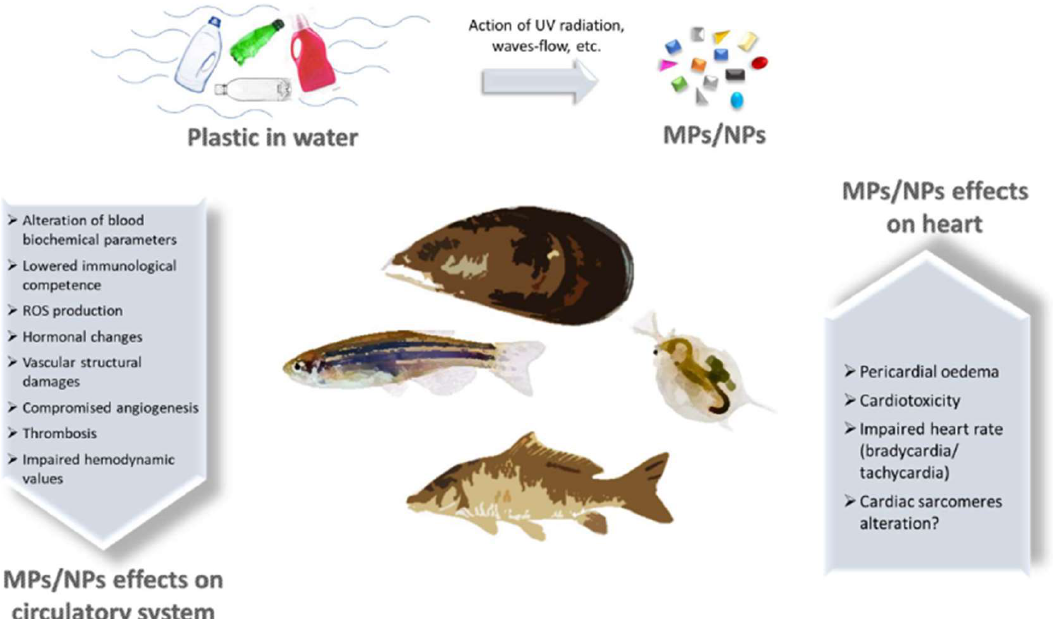
Figure 1. Scheme of MPs and NPs effects on cardiovascular system of aquatic organisms. Plastic wastes in water are prone to segregation due to the concerted action of UV-radiation, waves and water flows, leading to the generation of MPs and NPs. These particles reach aquatic fauna and enter the body, where they exert a plethora of detrimental effects on circulatory system and heart.